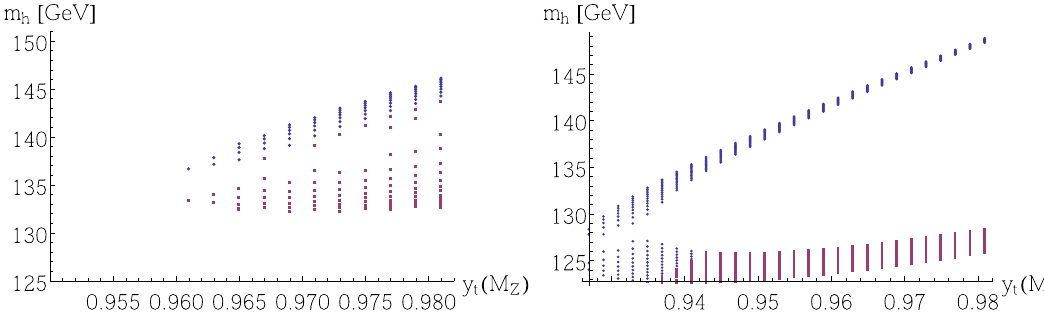
Fig. 13 Mass region of the SM-like CP-even scalar Higgs boson from 1 σ quark mass uncertainties against the top Yukawa initial value y t ( M Z ) for tan β = 60 (left) and tan β = 64 (right). Stable solutions are marked in blue, unstable solutions in